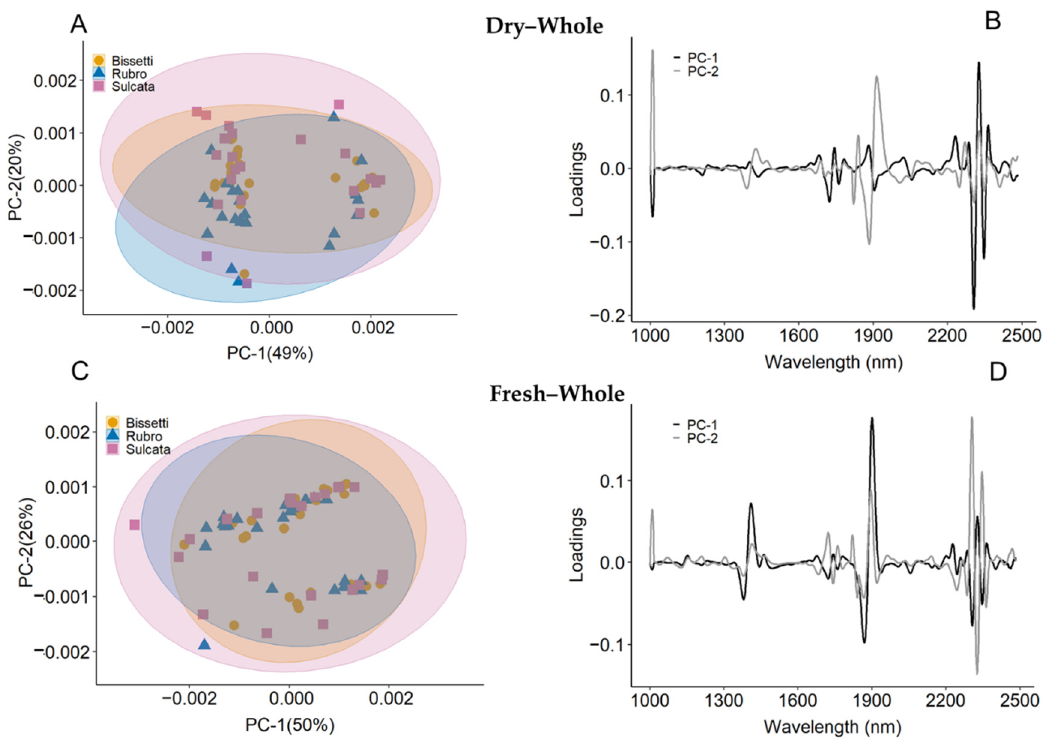
Figure 6. PCA scores plot ( A ) and loadings plot ( B ) for spectra collected from Dry–Whole bamboo samples. PCA scores plot ( C ) and loadings plot ( D ) for spectra collected from Fresh–Whole bamboo samples.